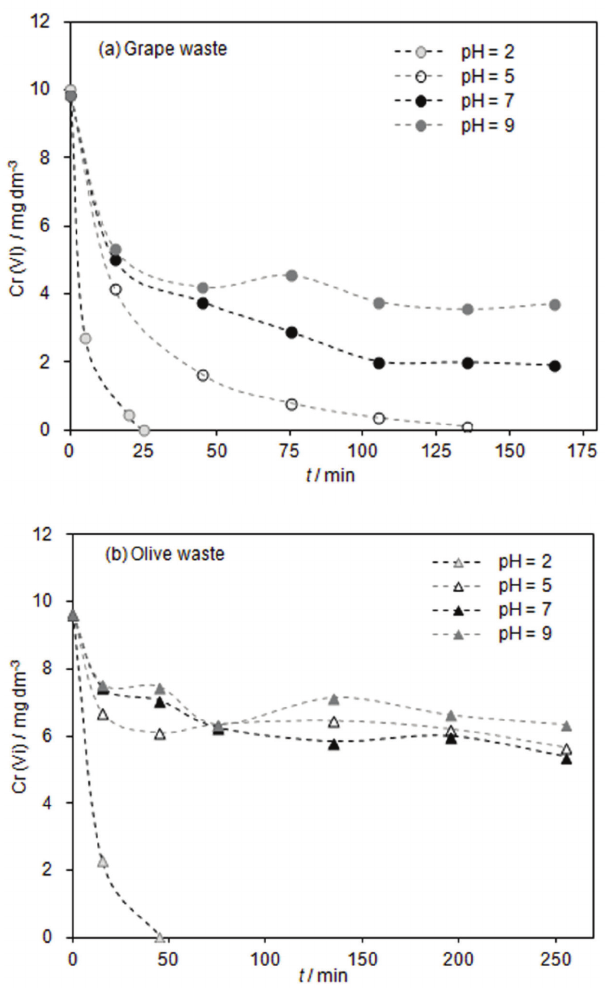
Fig. 2 – Effect of pH value on the adsorption of Cr(VI) on grape waste (a) and olive waste (b) (γ cm 3 , m = 0.5 g and T = 20